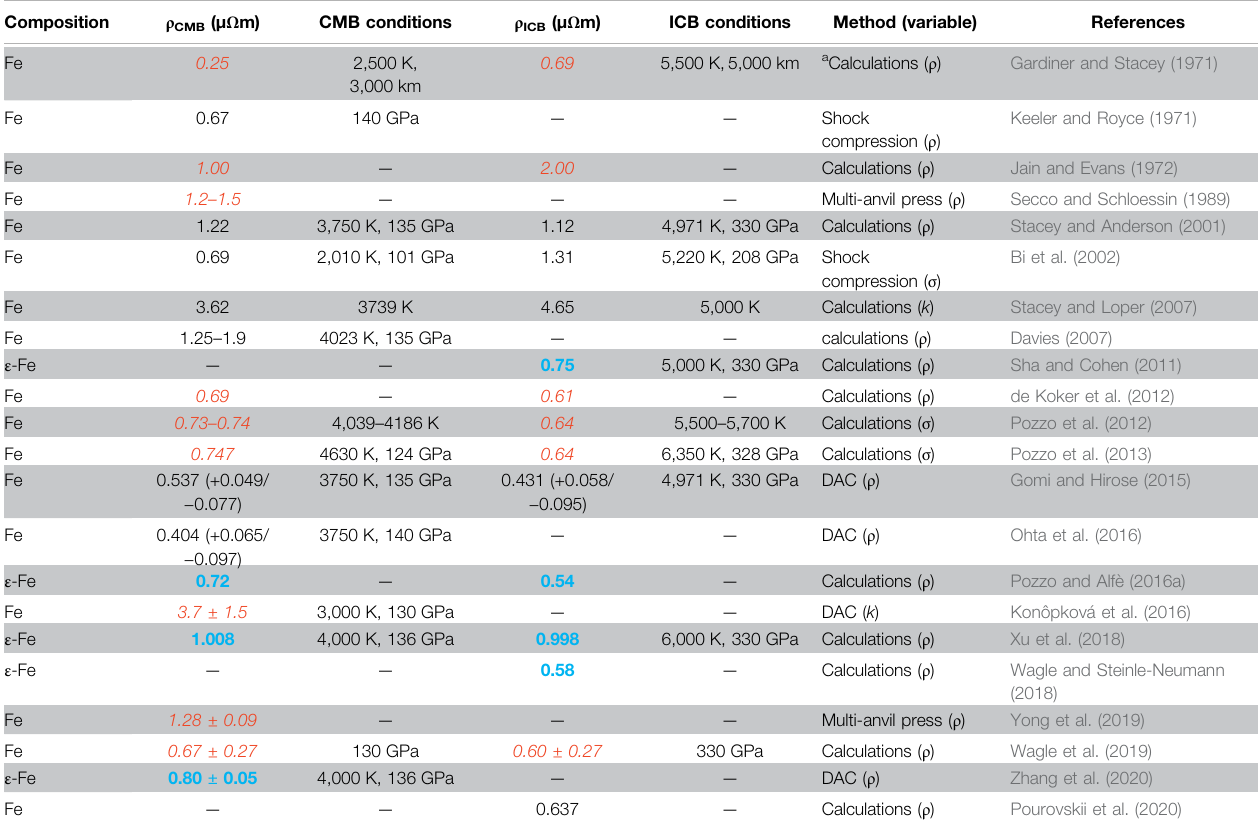
TABLE 1 | Electrical resistivity values of Fe at Earth ’ s CMB (4,000 K, 136 GPa) and ICB (5,000 K, 330 GPa) conditions determined by different methods. Composition